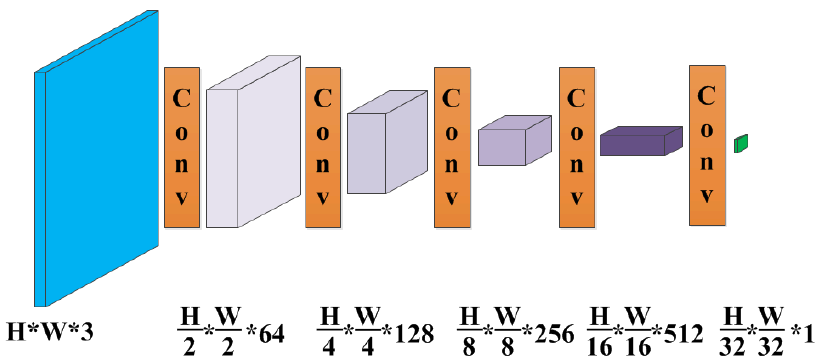
Figure 7. The PatchGAN architecture as the discriminator. Each “Conv” contains sequence Conv- BN-ReLU. The kernel size of each convolution operation is 3 × 3, the stride is 2 × 2, and the padding is 1 × 1. The input and output channel numbers can be obtained according to the parameters in the